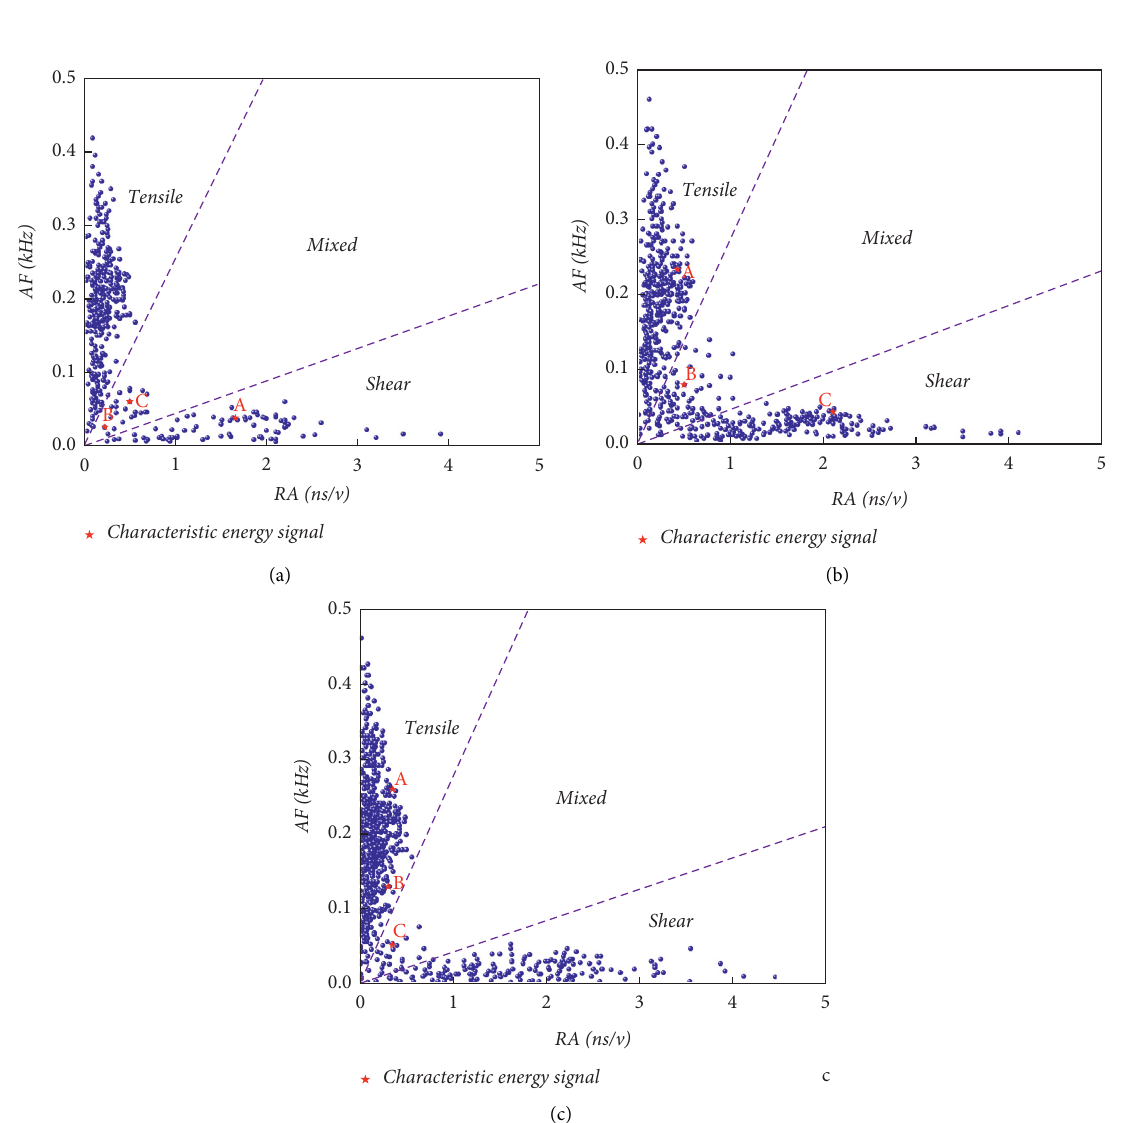
Figure 6: RA-AF damage analysis of different coal masses. (a) Sample C